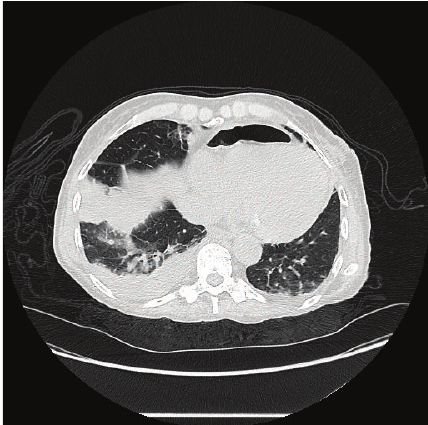
Figure 2: Thoracic CT reveals a loop of bowel incarcerated into the pericardial cavity. This image can be easily mistaken for pneu- mopericardium secondary to postoperative changes. Right lower lobe consolidation may be appreciated as